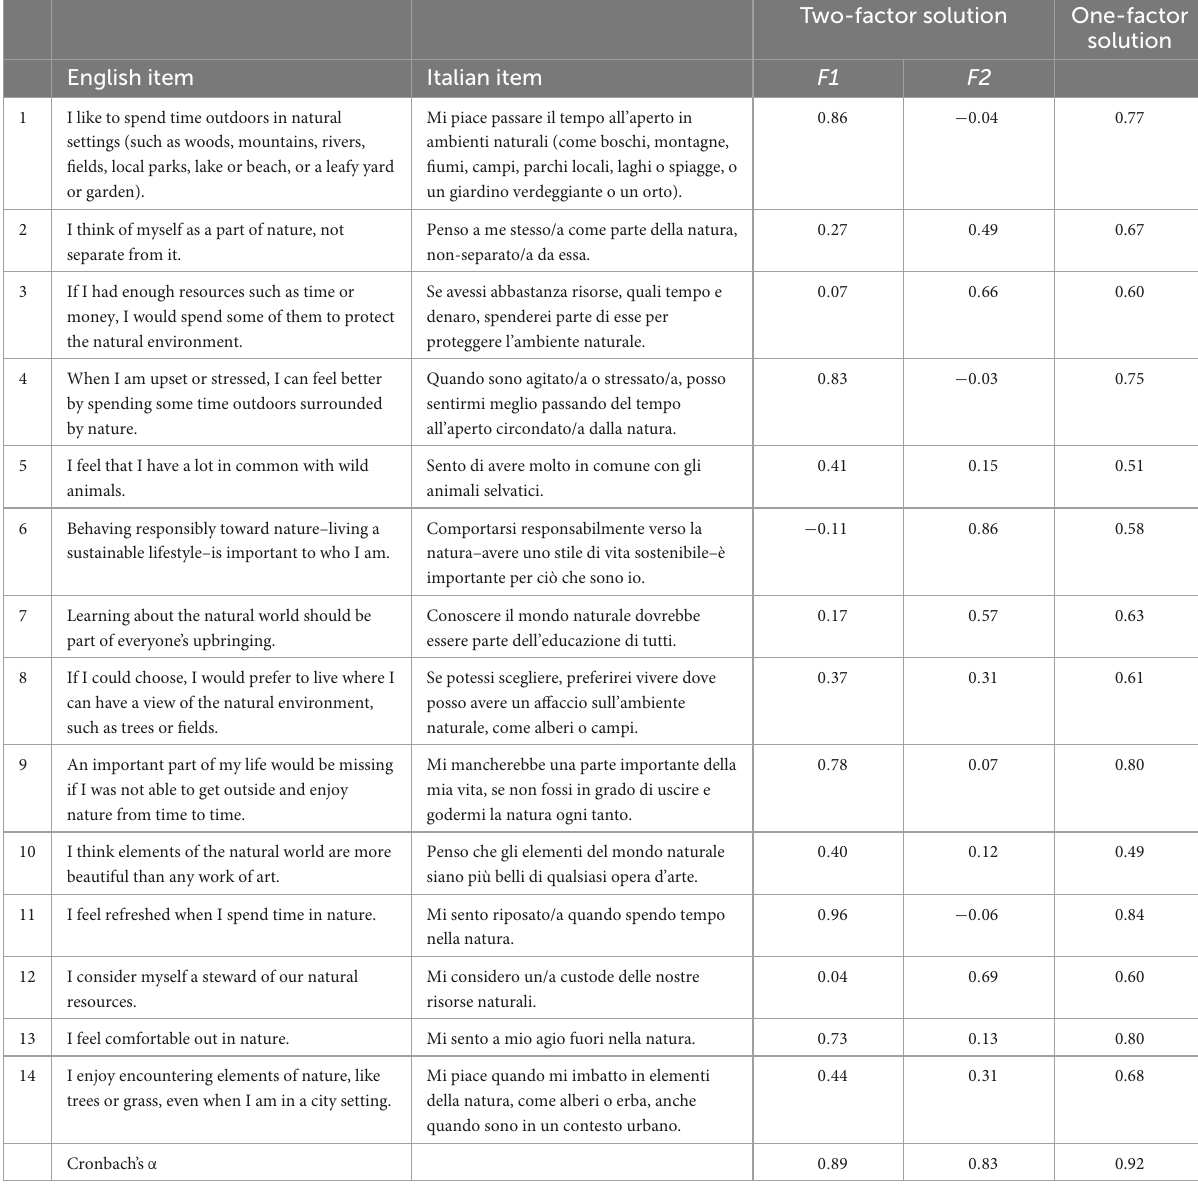
TABLE 1 Two-factor and one-factor exploratory factor analysis (EFA) solutions for the Italian revised environmental identity (EID) scale.